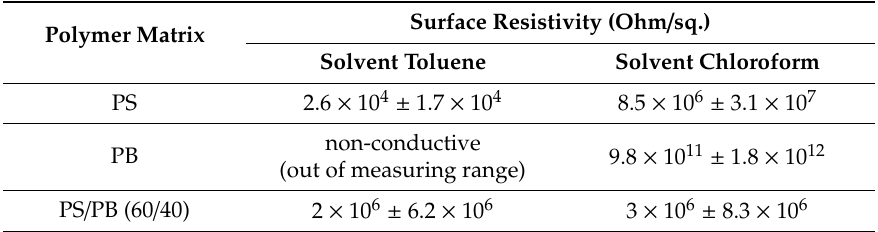
Table 2. Surface resistivity of polymer / NC 7000 composite